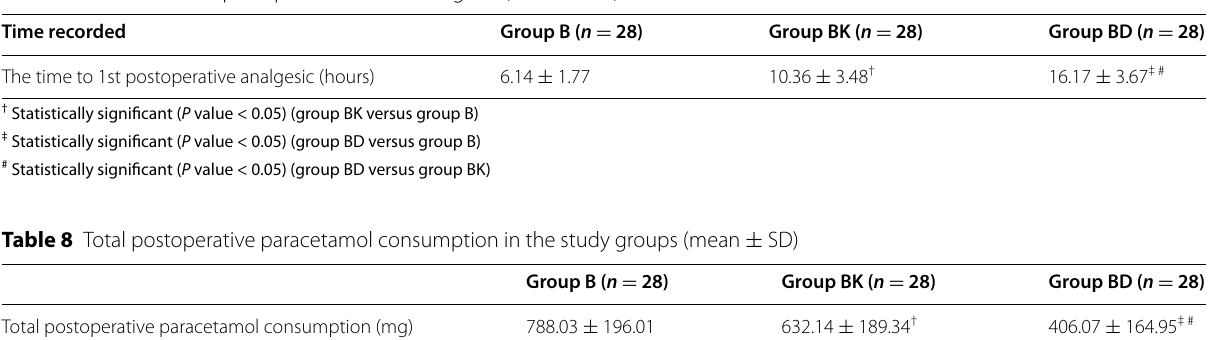
† Statistically significant ( P value < 0.05) (group BK versus group B) ‡ Statistically significant ( P value < 0.05) (group BD versus group B) # Statistically significant ( P value < 0.05) (group BD versus group BK)